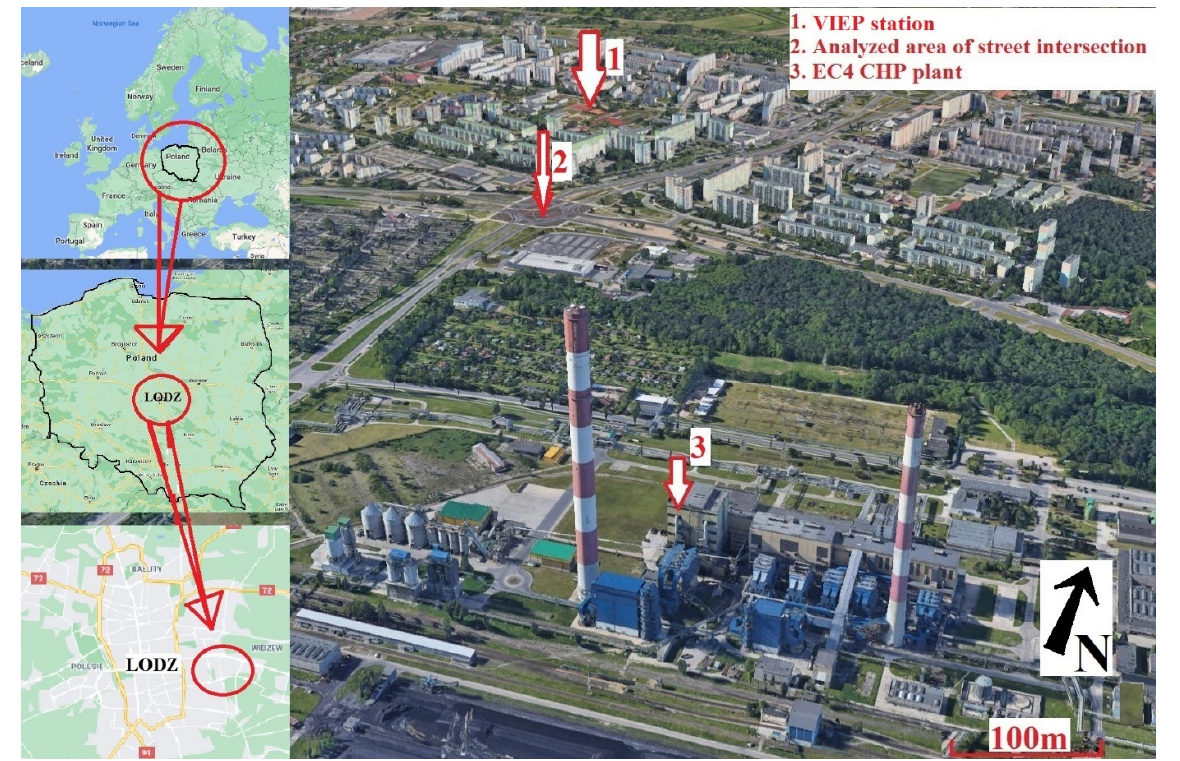
Figure 1. Map of the analyzed area and its surroundings: 1—Voivodship Inspectors of Environmental Protection (VIEP); 2—analyzed intersection of streets; 3—heat and power plant EC4 (photo background source: Google Earth Pro).